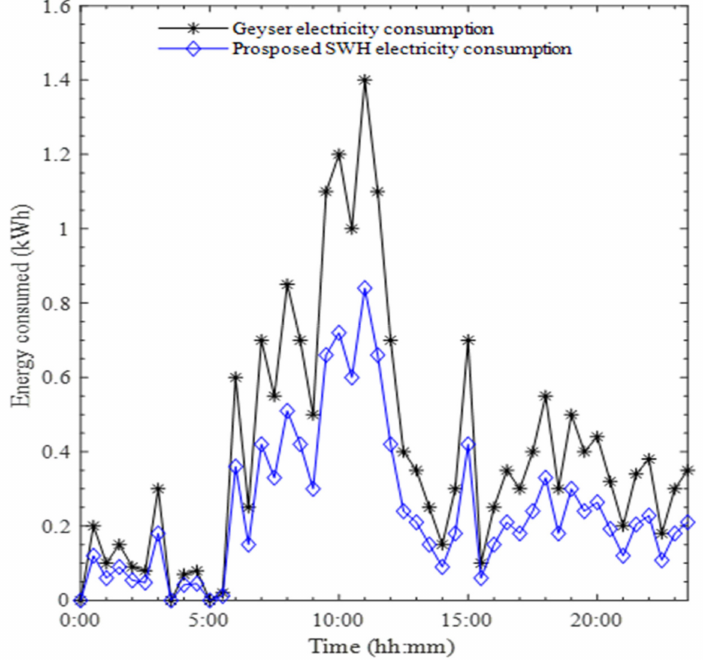
Figure 4. Average month–day electrical energy profiles of the electric water heater (geyser) and hybrid solar water heater